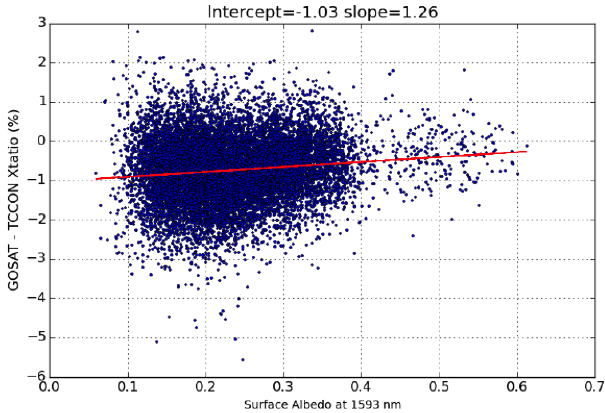
Figure A1. Linear regression analysis between GOSAT–TCCON X ratio and surface albedo at 1593nm.